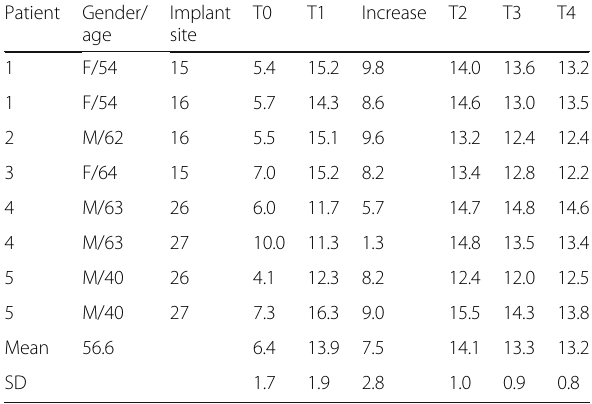
Table 1 Alveolar tissue height measurements on panoramic radiographs (in true mm) in the 9-month group Patient Gender/ age